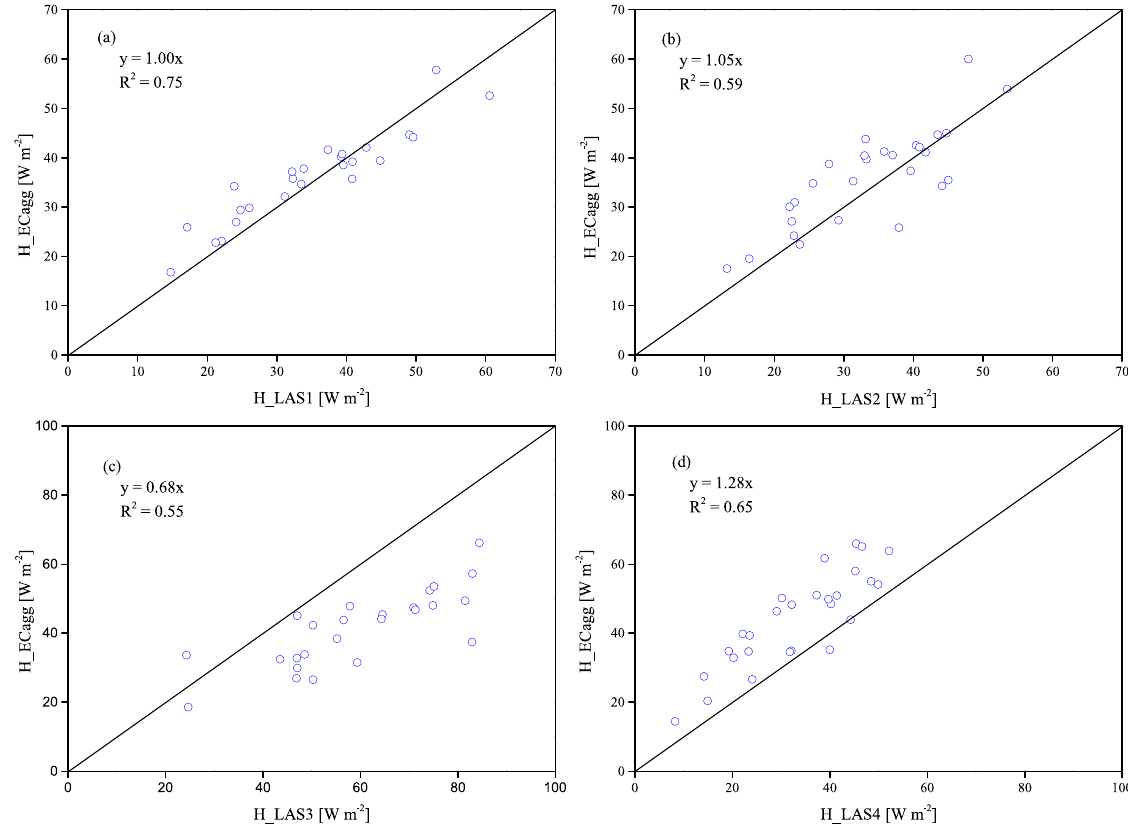
Figure 7. The comparison between LAS observed fluxes ( x axis) and EC aggregated fluxes ( y